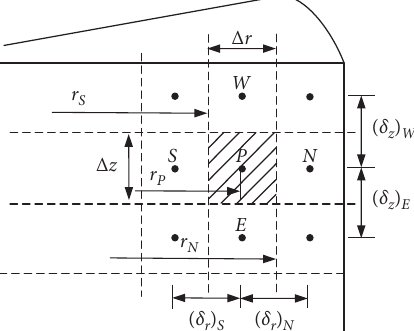
Figure 1: Schematic of mesh generation for fuel pellets or